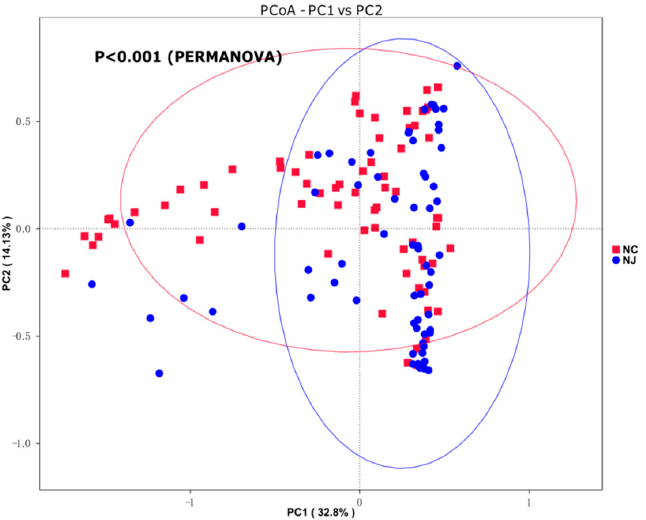
Figure 1. Diversity and variability of the neonatal gut microbiota. The same color is used for the same group of samples; red represents healthy controls; blue represents neonatal jaundice, and each point represents one sample. ( a ) Species richness in the feces of neonates with jaundice and healthy controls; few samples in either group had >2000 microbial species. Most were <1000, and the NJ group had significantly fewer gut microbes. ( b ) Diversity of fecal microorganisms in both groups. The vertical coordinate represents the Shannon index, with larger values indicating a higher response biodiversity (i.e., more species meant that the samples were more evenly distributed). The fecal microbiota diversity was significantly lower in neonates with jaundice than in the controls. *** p value < 0.001.